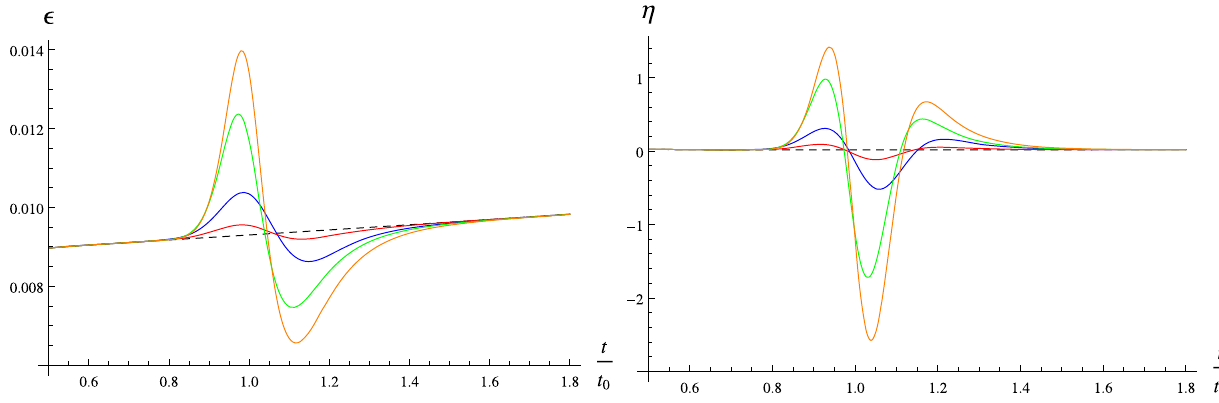
Fig. 1 Thenumericallycomputedslow-roll parameters (cid:6) and η around the feature time t 0 for λ = − 4 × 10 − 12 ,σ = 0 . 05, and k 0 = 1 . 2 × 10 − 3 ( blue ), λ = − 10 − 12 ,σ = 0 . 05, and k 0 = 1 . 3 × 10 − 3